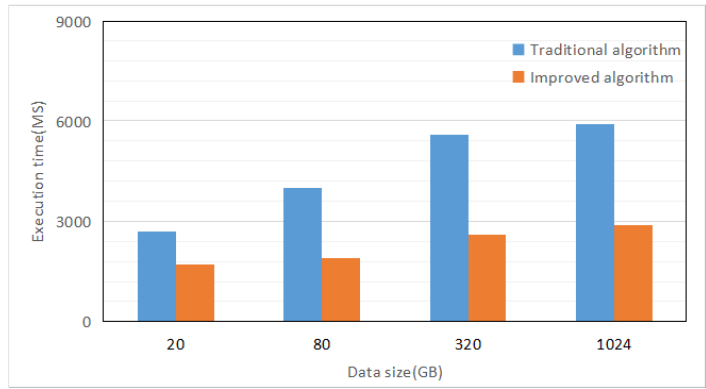
Figure 5. Execution time for different data volumes.